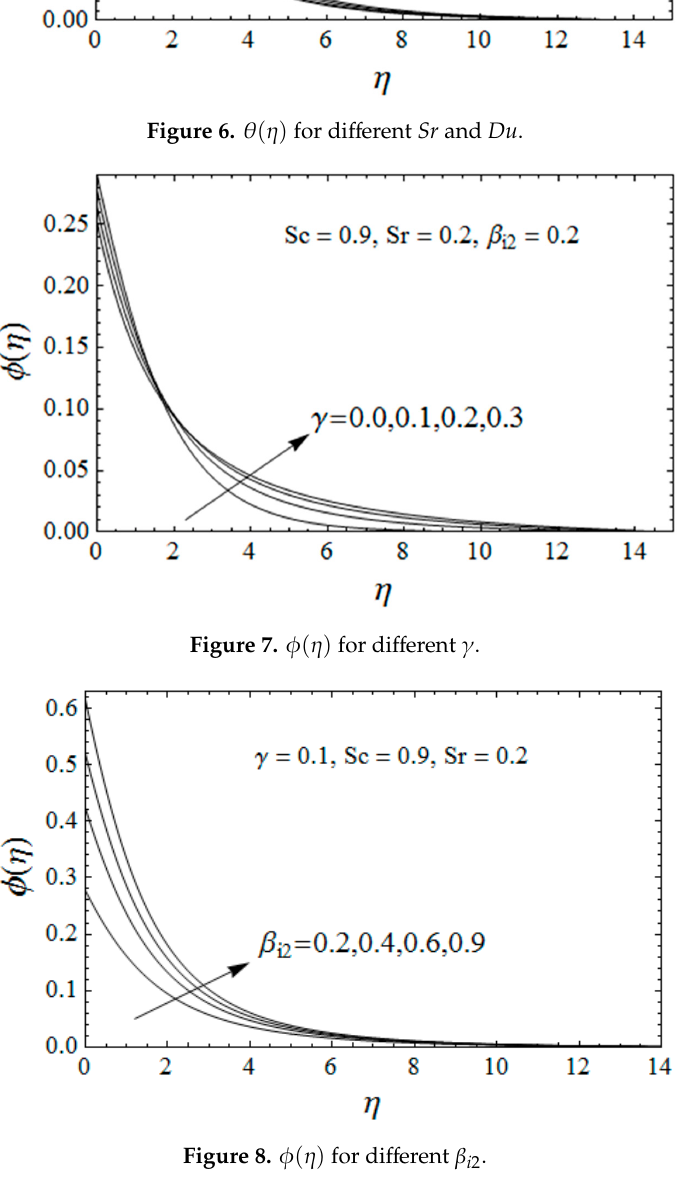
Figure 8. 𝜙(𝜂) for different 𝛽 (cid:3036)(cid:2870) .